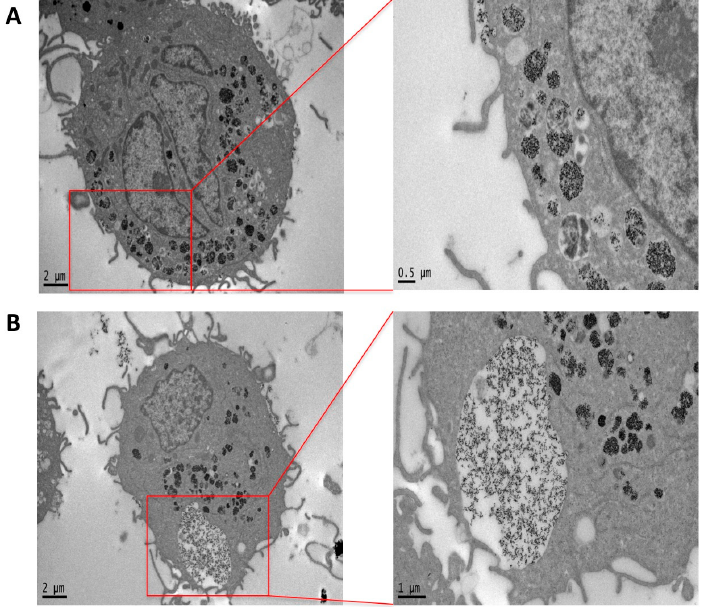
Figure 4. TEM images of pre-differentiated THP-1 cells treated with 50 µ g/mL PtNPs for 24 h showing the endocytotic ( A ) and phagocytotic ( B ) process.